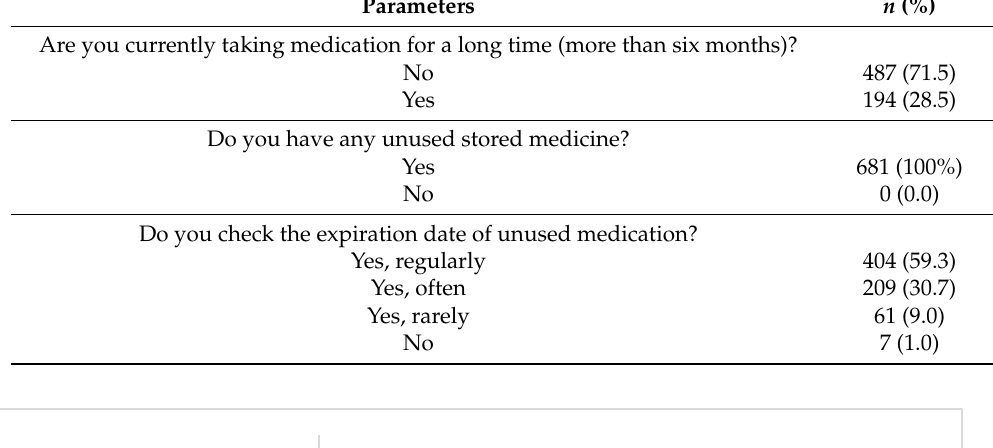
Table 2. Medication-related information of the study participants ( n = 681).